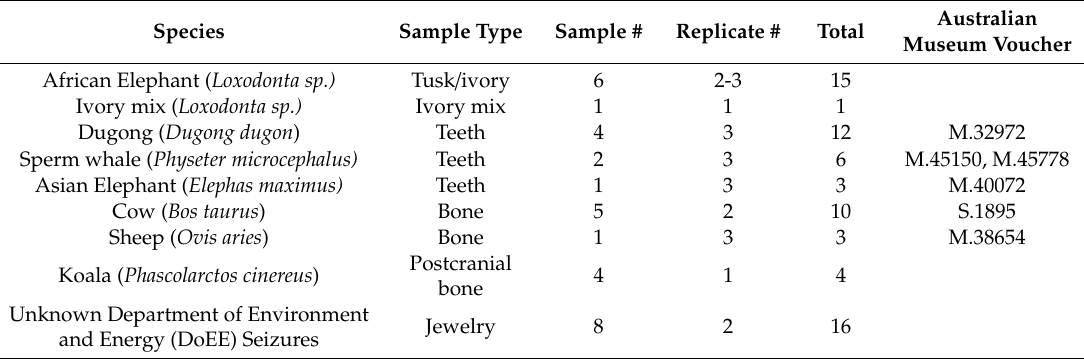
Table 2. Sample type, number and replicate